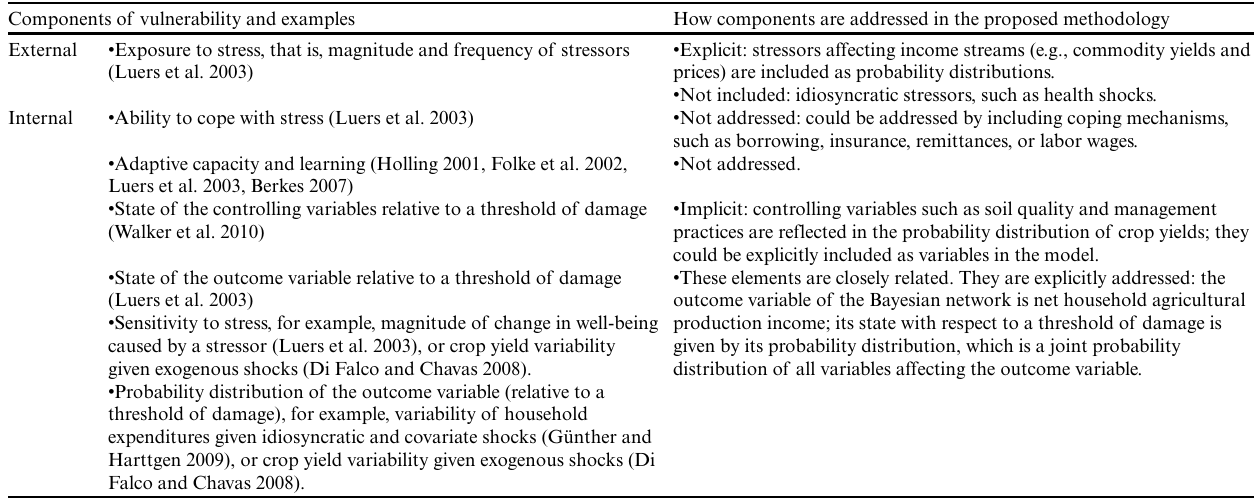
Table 1 . Social-ecological vulnerability